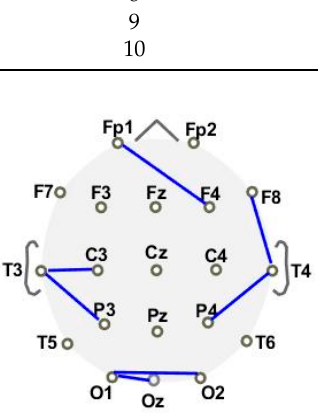
Figure 2. A rough schematic drawing which shows the selected features by connections (solid thick blue lines).